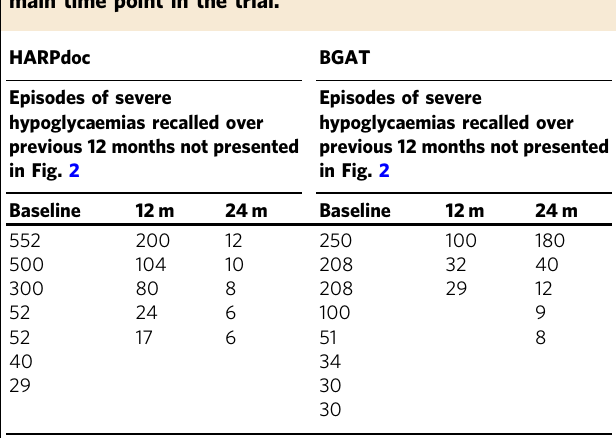
Fig. 2 A box plot to present the summary statistics of the number of SH events in the previous 12 months (primary endpoint) by treatment arm and time point. The grey box represents the 25 – 75% interquartile range, the median is represented by the white line in each box and the whiskers cover the minimum to the maximum values, to the limit of 1.5× the IQR. Individual values for rates outside this limit have been excluded for clarity and are presented in Table 5. A three-level random intercept negative binomial model has been used, using a missing at random assumption (MAR) and a signi fi cance level of 2.5% (two sided). The N for each group is baseline: 49 and 50, 12 months 42 and 45 and 24 months 41 and 42 HARPdoc and BGAT respectively. Source data are available on request to SAA or IB, as described in the text. Table 5 Numbers of severe hypoglycaemia episodes recalled over previous 12 months by individual participants that exceed 1.5× the interquartile range for the group at each main time point in the